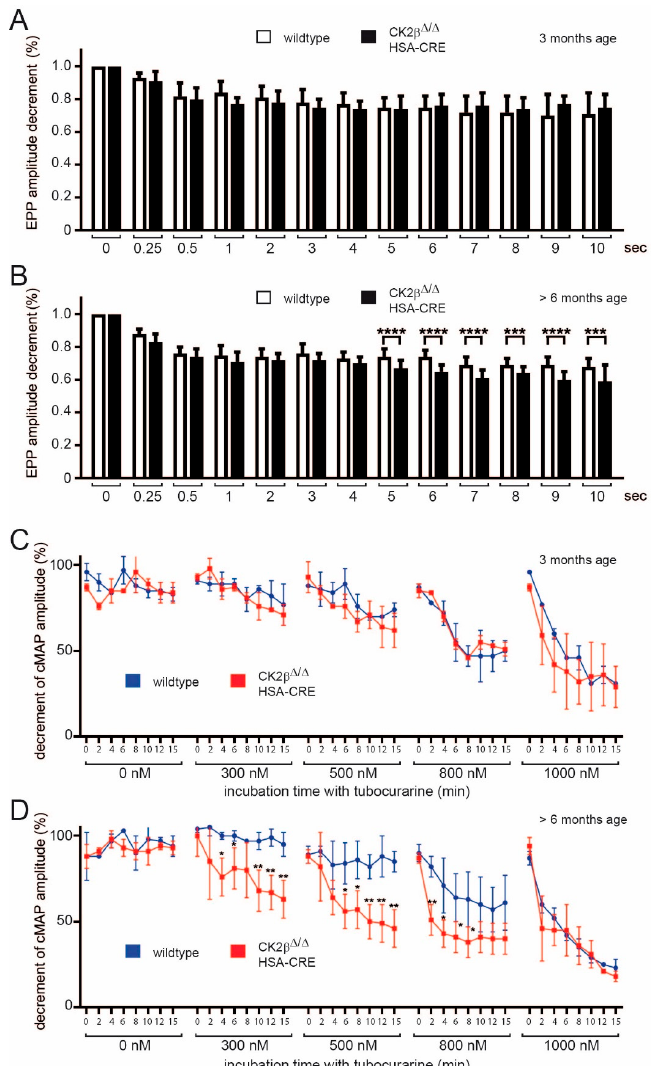
Figure 3. CK2 β -ablation in skeletal muscles altered neuromuscular synapse function and affected safety factor in >6-months-old but not in 3-months-old conditional CK2 β deficient mice. ( A , B ) Decrement of the endplate potential amplitude in wild-type and CK2 β -deficient diaphragm muscles in 3-months-old mice ( A ) and >6-months-old mice. ( C , D ) Compound muscle action potential (CMAP) measurements in 3-months-old ( C ) and >6-months-old ( D ) wild-type and CK2 β -deficient diaphragms under untreated conditions and in the presence of increasing concentrations (300, 500, 800, and 1,000 nM) of D -tubocurarine. The >6-months-old CK2 β -deficient animals showed a significantly higher decrement of CMAP, which was already displayed at 300 nM D -tubocurarine, thus unmasking a reduced safety factor in the absence of CK2 β (*** p < 0.001; ** p < 0.01; * p < 0.05; unpaired two-tailed Student’s t-test; n = 3–5 mice, each genotype). Error bars indicate s.e.m.